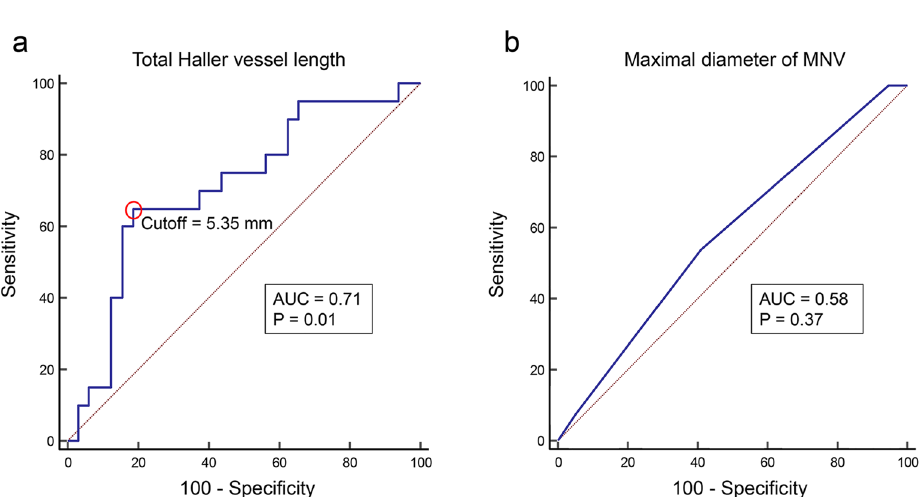
Figure 3. The receiver operating characteristic (ROC) curve based on statistically significant factors identified using multiple logistic regression analyses for visual acuity gain and number of treatments over 1 year. ( a ) ROC curve of the injection frequency based on the total Haller vessel length; the area under the curve (AUC) was as high as 0.71 (P = 0.01). The cutoff value was set at 5.35 mm (open red circle). ( b ) ROC curve of the visual acuity gain based on the maximal macular neovascularization diameter. The AUC was 0.58, although no statistical significance was observed (P =